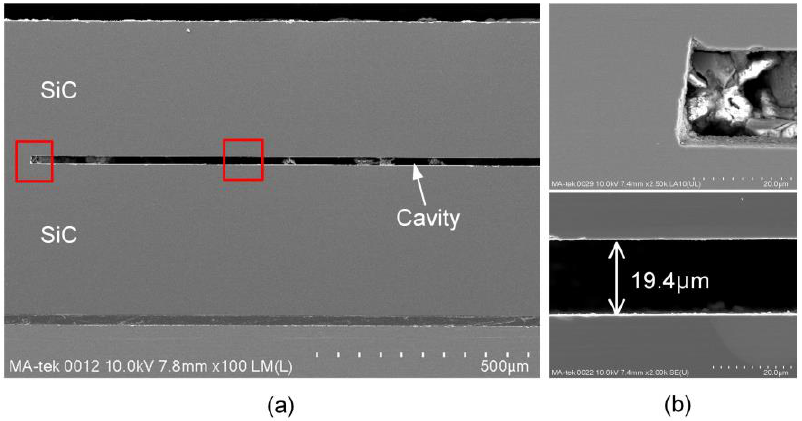
Figure 5. SEM images of the SiC cavity structure: ( a ) cross-sectional image of the bonded structure; ( b ) the magnified rectangular areas in ( a ). ( b ) the magnified rectangular areas in ( a